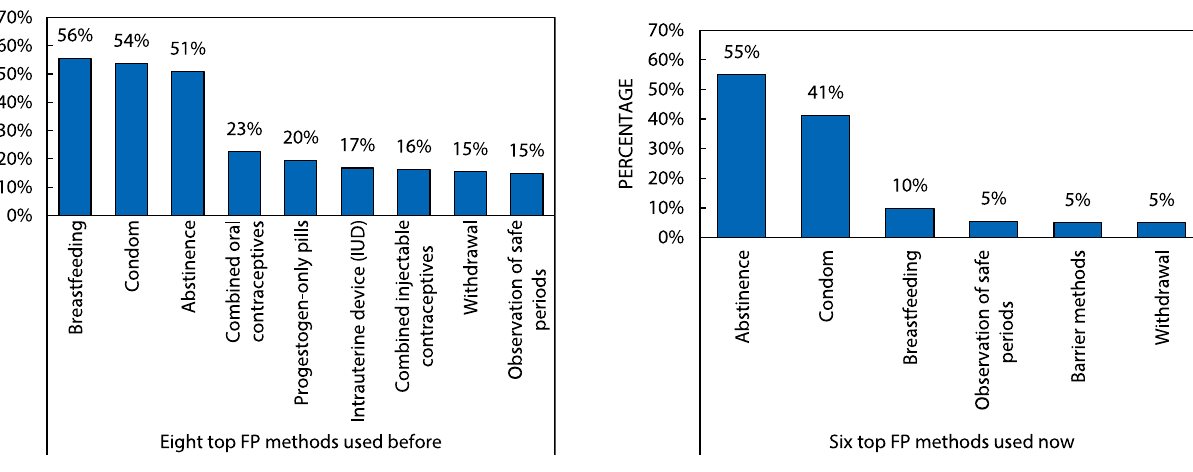
Figure 2: Family planning methods used beforehand. Figure 3: FP methods older adults use